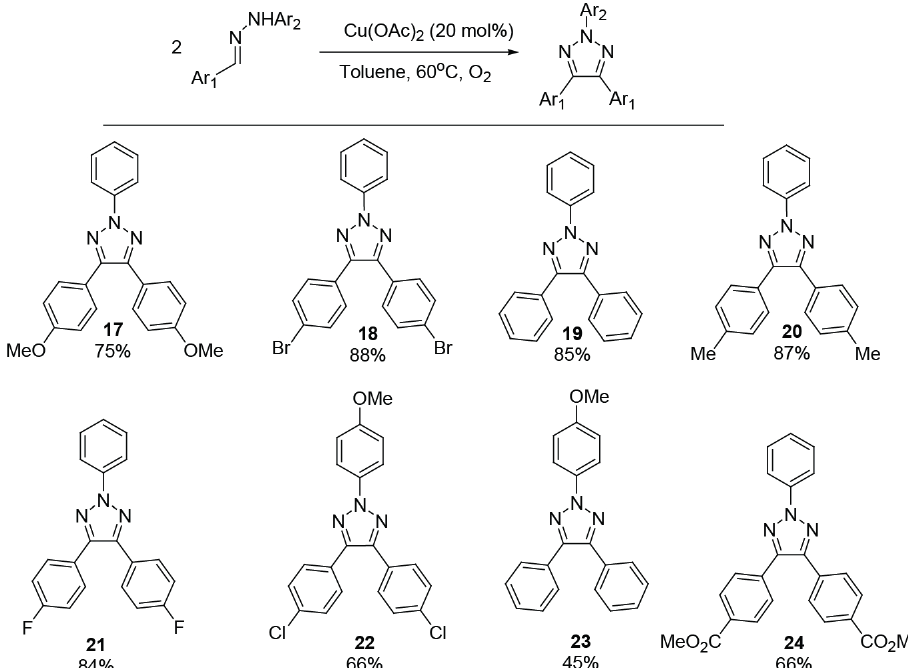
Figure 7 - Synthesis of symmetric N 2 substituted 1,2,3-triazoles from